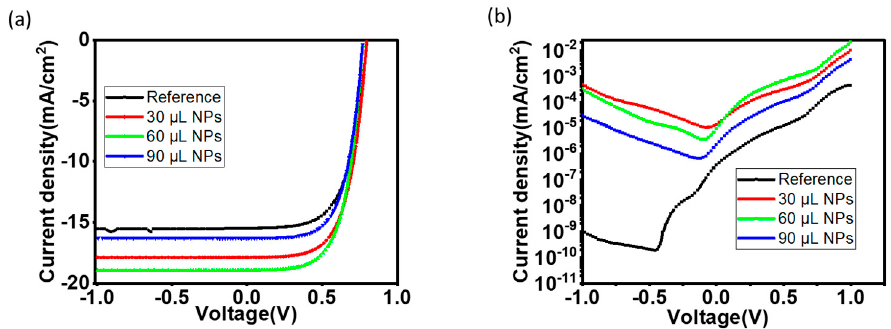
Figure 3. ( a ) J-V characteristics, recorded under illumination at 100 mW cm − 2 (AM 1.5G) of devices with incorporated Au-Ag NPs in the PEDOT: PSS at different concentrations; ( b ) semi-log of the absolute value of the J-V characteristics in the dark.